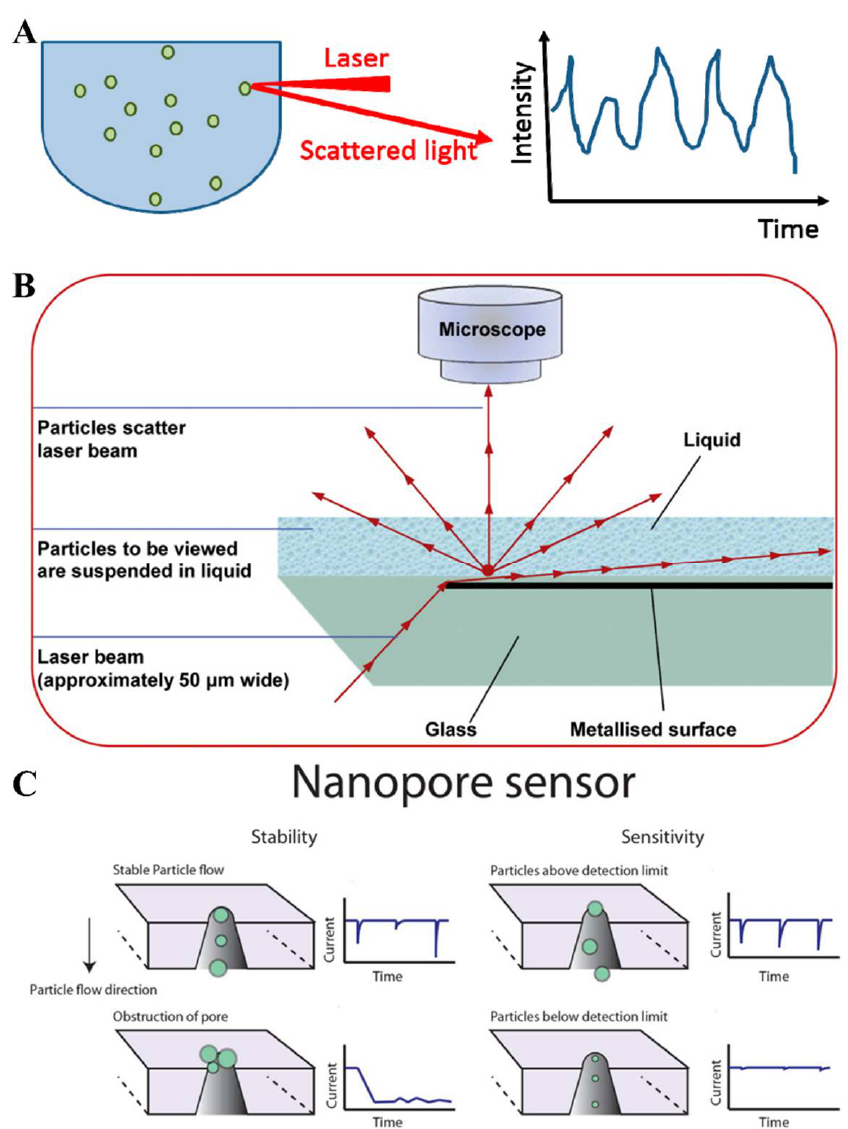
Figure 2. ( A ) DLS detects the scattered light intensity from the particles undergoing the Brownian motion in a solution that fluctuates over time. Reprinted with permission from [46]. Copyright 2017, Multidisciplinary Digital Publishing Institute. ( B ) Nanoparticle tracking analysis (NTA) utilizes the Brownian motion and light scattering to determine the particle size in solution. The scattered light from the particles is captured by a digital camera. Reprinted with permission from [49]. Copyright 2011, Elsevier. ( C ) In tunable resistive pulse sensing (TRPS), the pore size could be reversibly adjusted, which enables the flexible detection of single particles of different sizes. Reprinted with permission from [52]. Copyright 2015, American Chemical Society.